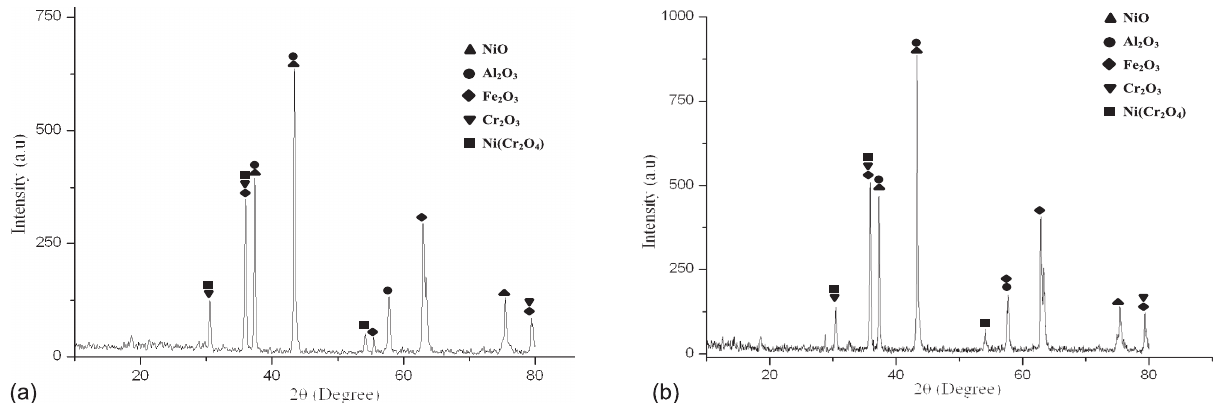
Fig. 8: XRD pattern for Inconel 617 exposed to corrosive environment at (a) 900 °C and (b) 1000